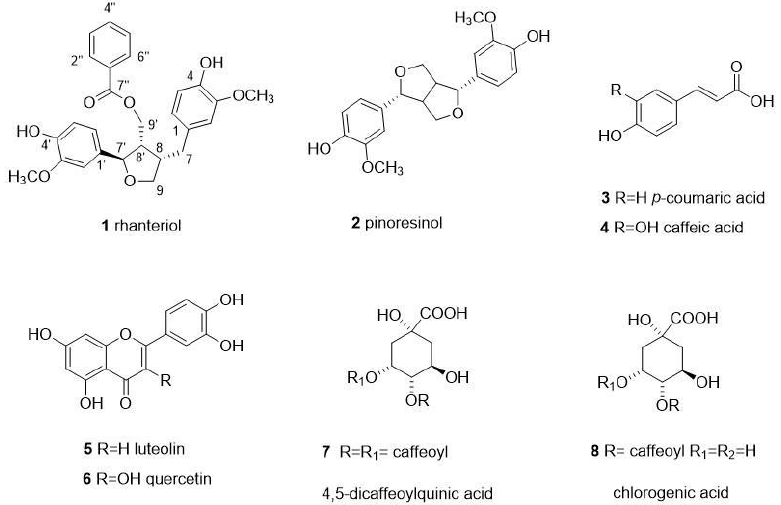
Figure 1. Compounds isolated from R. suaveolens methanol extract.